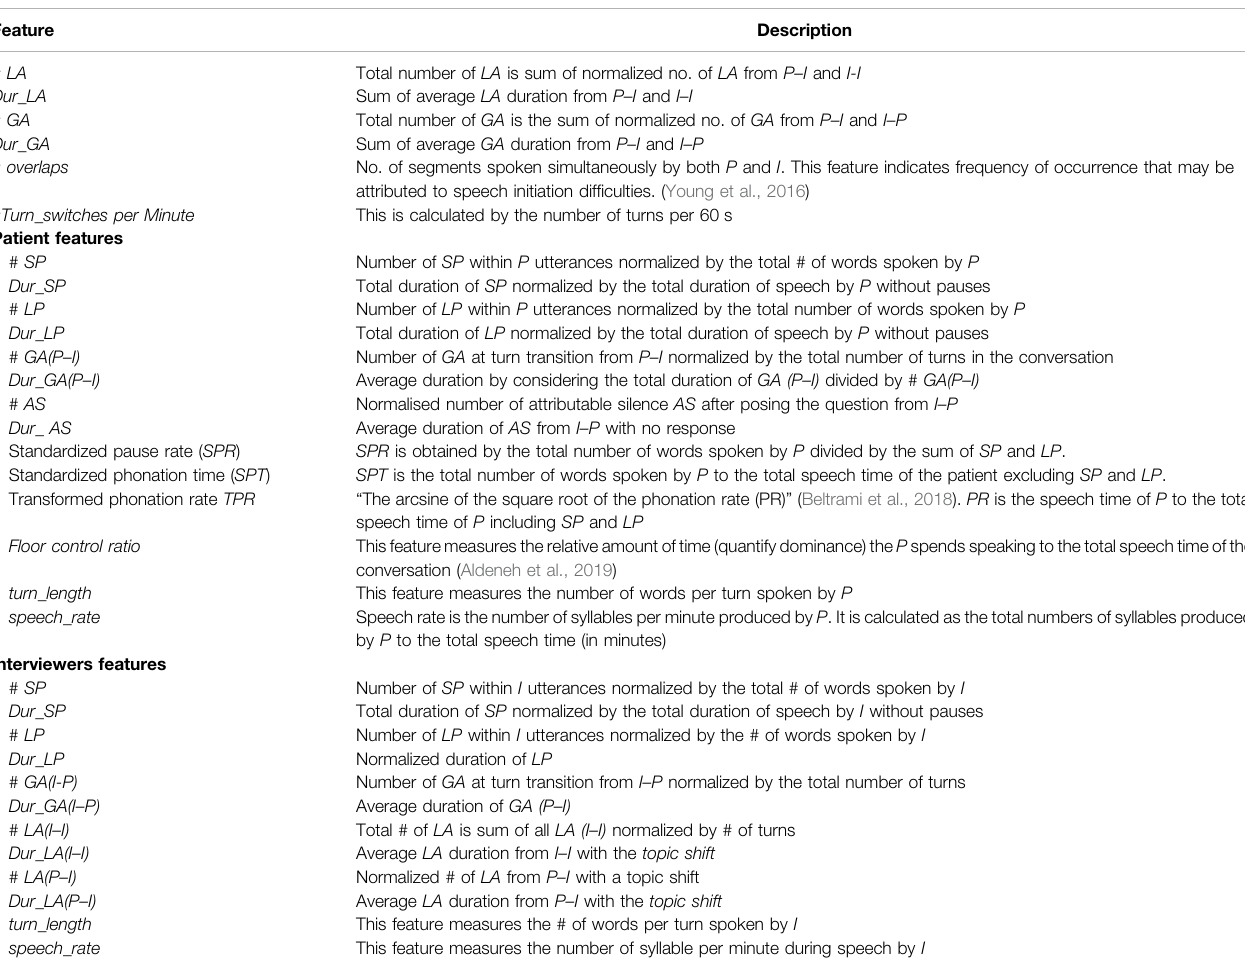
TABLE 4 | The proposed interactional feature